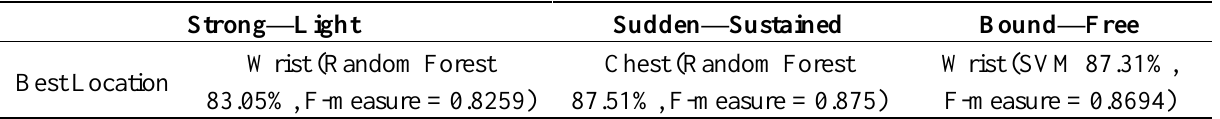
Table 8. Best location to place a single accelerometer to detect subcategories within the Effort category.